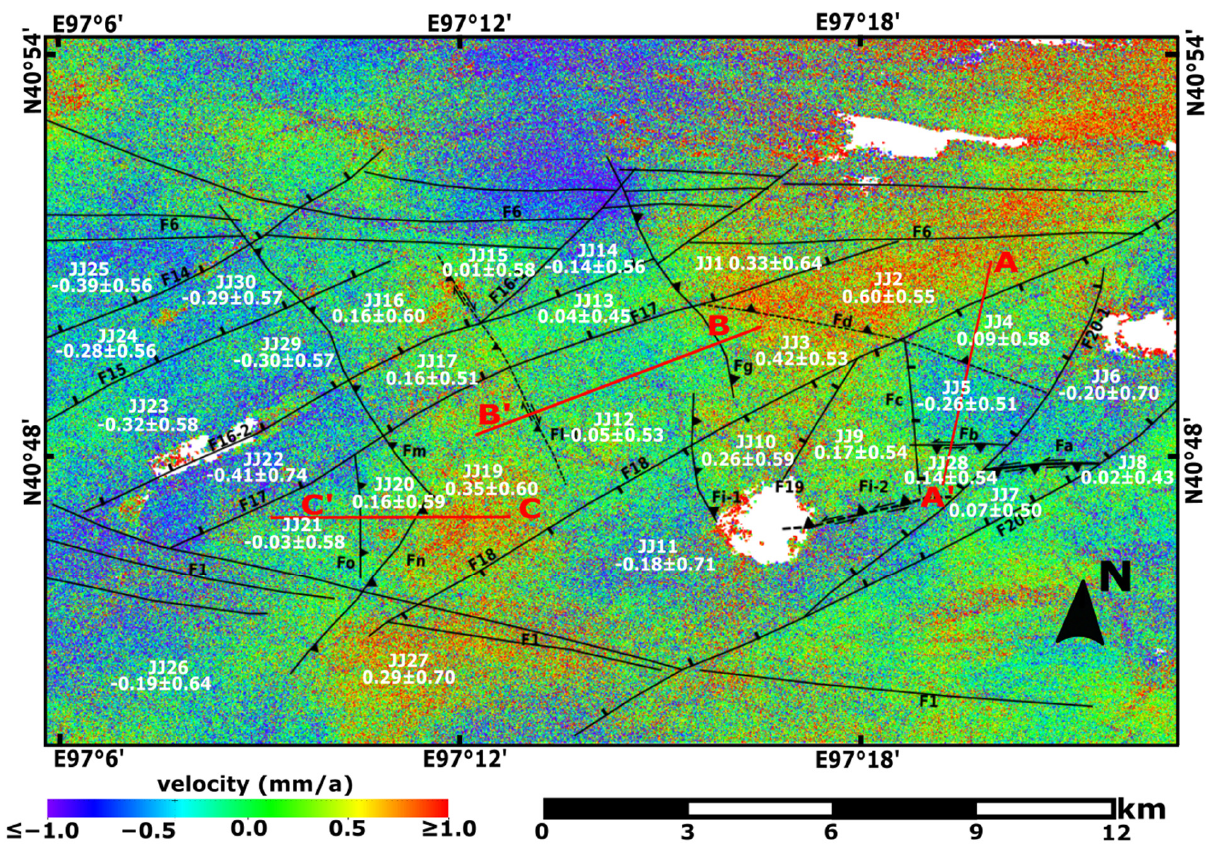
Figure 6. The pattern of vertical deformation (D U ) in the Jiujing region, where the positive values (upper, red side of colour axis) refer to the uplift and negative values (blue, lower side of colour axis) refers to subsidence. Values in white text indicate movement rates with standard deviations in mm a − 1 and the full data are presented in Table S1 in Supplementary Materials.